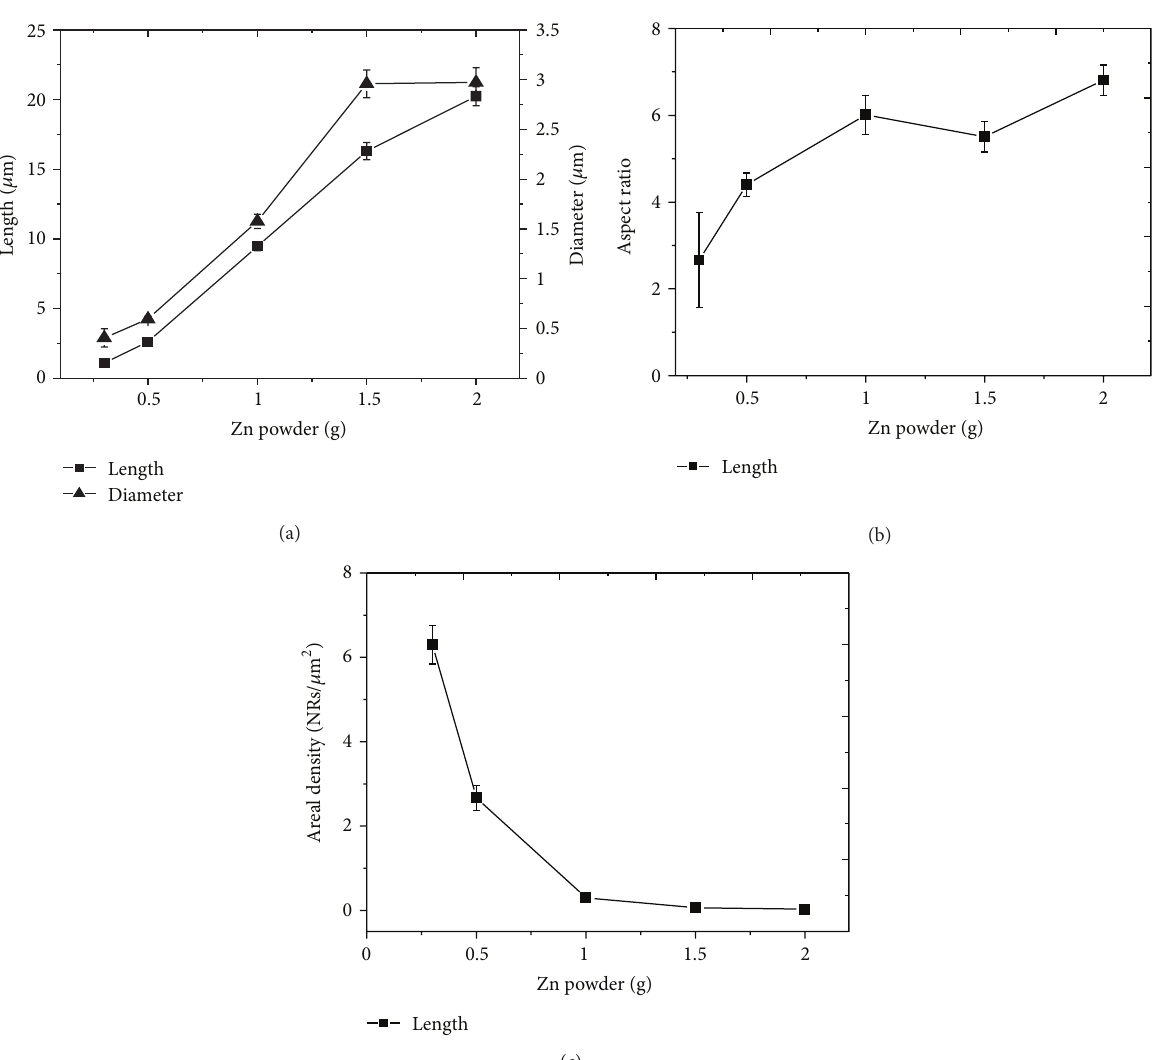
Figure 6: Effect of amount of Zn powder on the growth of ZnO rods: (a) length and diameter, (b) aspect ratio, and (c) areal density.